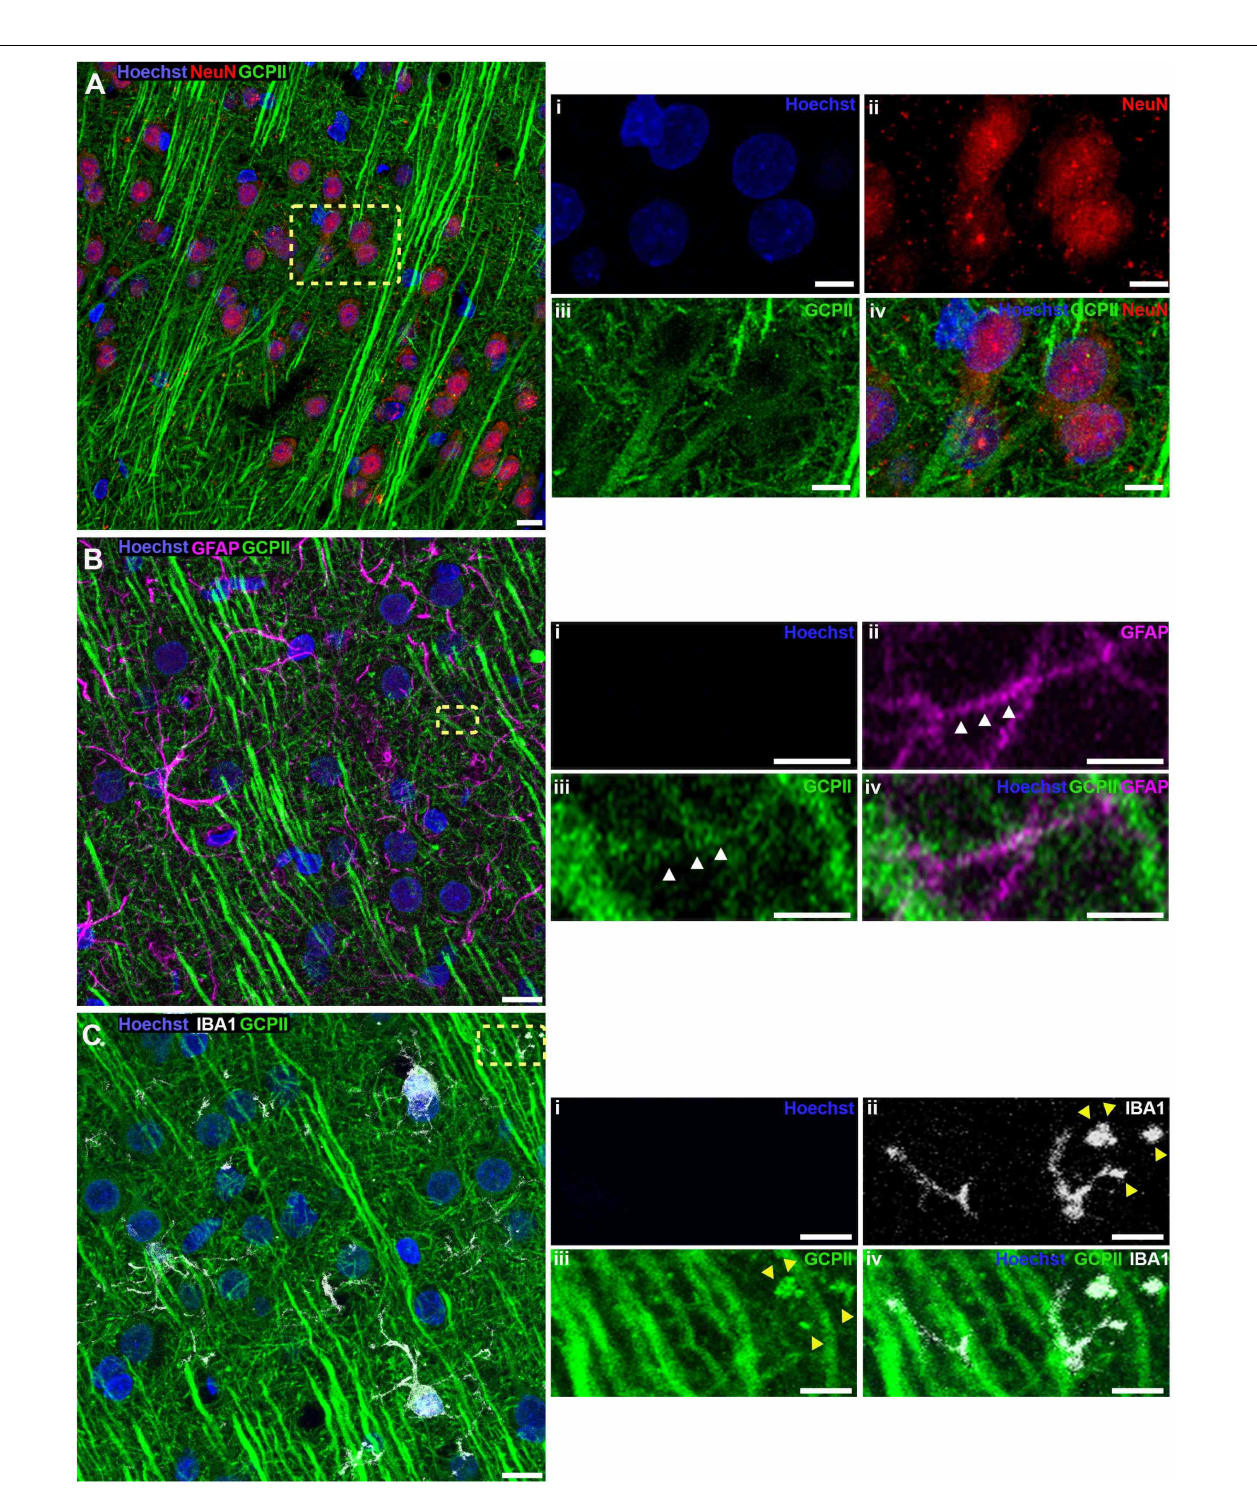
FIGURE 2 | Neuronal, astrocytic, and microglial expression of GCPII in layer II/III of rat PFC by IF. (A) Representative confocal images of aged rat layer II/III PL mPFC stained for NeuN ( red) , GCPII (green) , and nuclei were counterstained with Hoechst ( blue) . Images taken at 63X magnification. (Ai–iv) Show magnified images by channel of the region outlined by the yellow dashed box on the composite image. Note the prominent presence of GCPII in the parallel apical dendrites projecting toward the pia and NeuN positive soma of pyramidal neurons, as identified by the white triangles. Scale bars: (A) 10 µ m , (Ai-iv) 5 µ m . (B) Representative confocal images of aged rat layer II/III PL mPFC stained for GFAP (magenta) , GCPII (green) , and nuclei were counterstained with Hoechst (blue) . Images taken at 100X magnification. (Bi–iv) Show magnified images by channel of the region outlined by the yellow dashed box on the composite image. Note the delicate labeling of